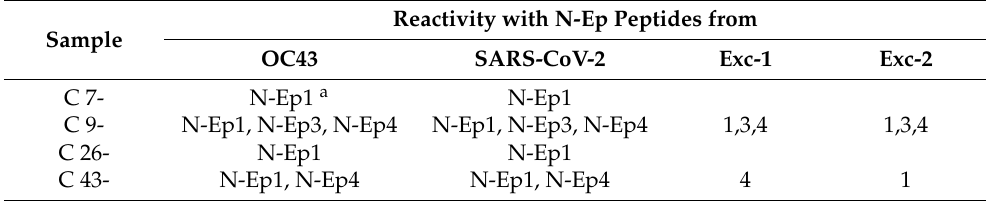
Figure 4. Reactivity against peptide candidates from SARS-CoV-2 and HCoV-OC43 N proteins in pre-COVID-19 cohort determined by ELISA assays. ( a ) Heatmap with OD450nm readings for each sample. Cutoff for negative binding was established at OD450 = 0.2. ( b ) Frequency of cross-reacting serum samples among all tested serum samples in the pre-COVID-19 cohort. Table 2. Summary of reactivity against peptides candidates with functional reactivity from HCoV-OC43 and SARS-CoV-2 N proteins in pre-COVID-19 cohort determined by ELISA assays. a The numbers indicate the positive ELISA assay from peptides indicated in Figure